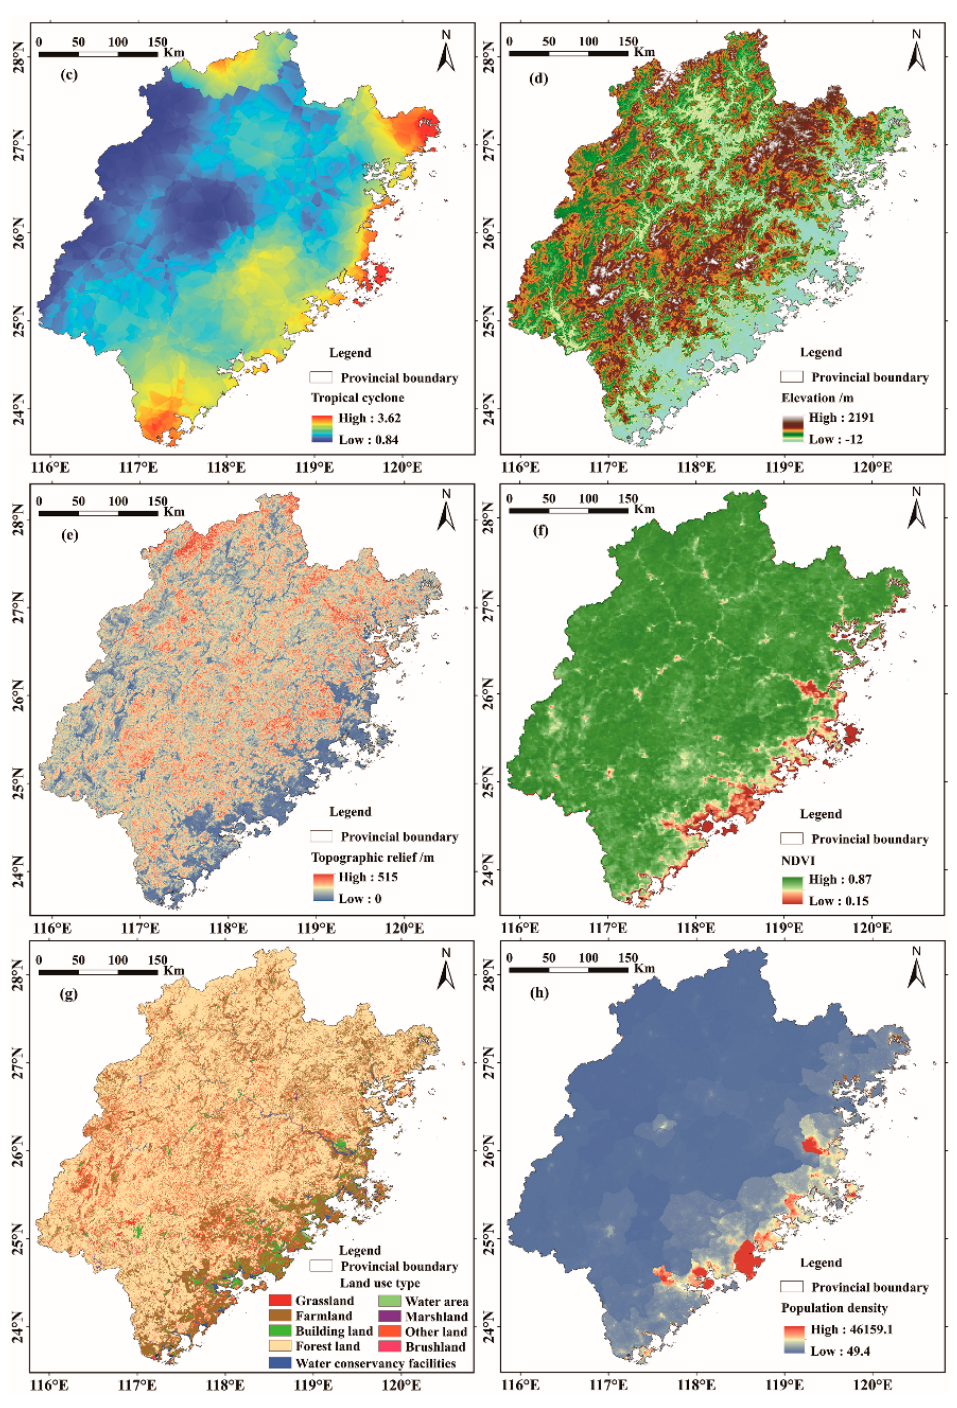
Figure 3. Eight assessment indicators: ( a ) H24_100, ( b ) annual rainfall, ( c ) tropical cyclone index, ( d ) elevation, ( e ) topographic relief, ( f ) NDVI, ( g ) land use type, and ( h ) population density.